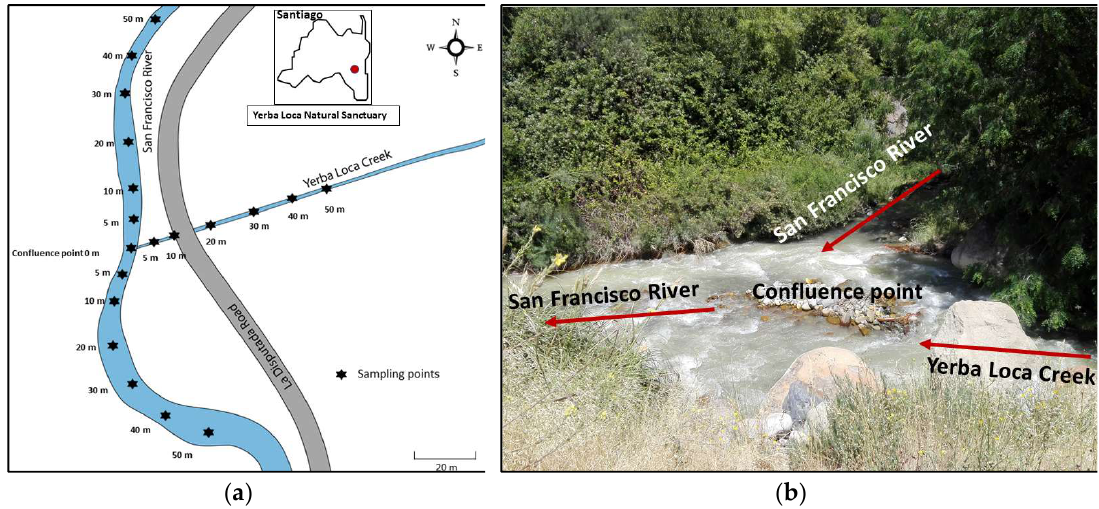
Figure 1. ( a ) Schematic representation of the study site at the confluence of the San Francisco River and Yerba Loca Creek, in the north-east of Santiago; ( b ) Photograph of the confluence point of both water courses.